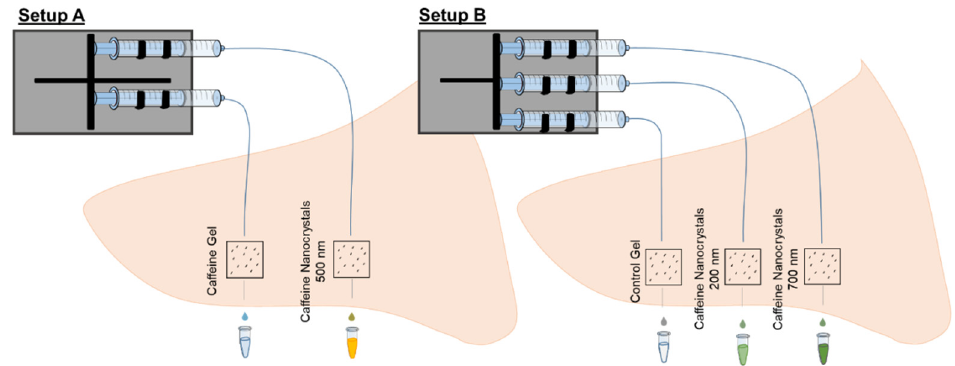
Nanomaterials 2021 , 11 , x FOR PEER REVIEW 5 of 13 Figure 1. Setup A: Two skin areas were prepared on each porcine ear. A gel formulation and nanocrystal gel formulation were applied. Setup B: Three skin areas were prepared on each porcine ear. A control formulation and formulations containing 200 nm nanocrystals and 700 nm nanocrystals were applied.